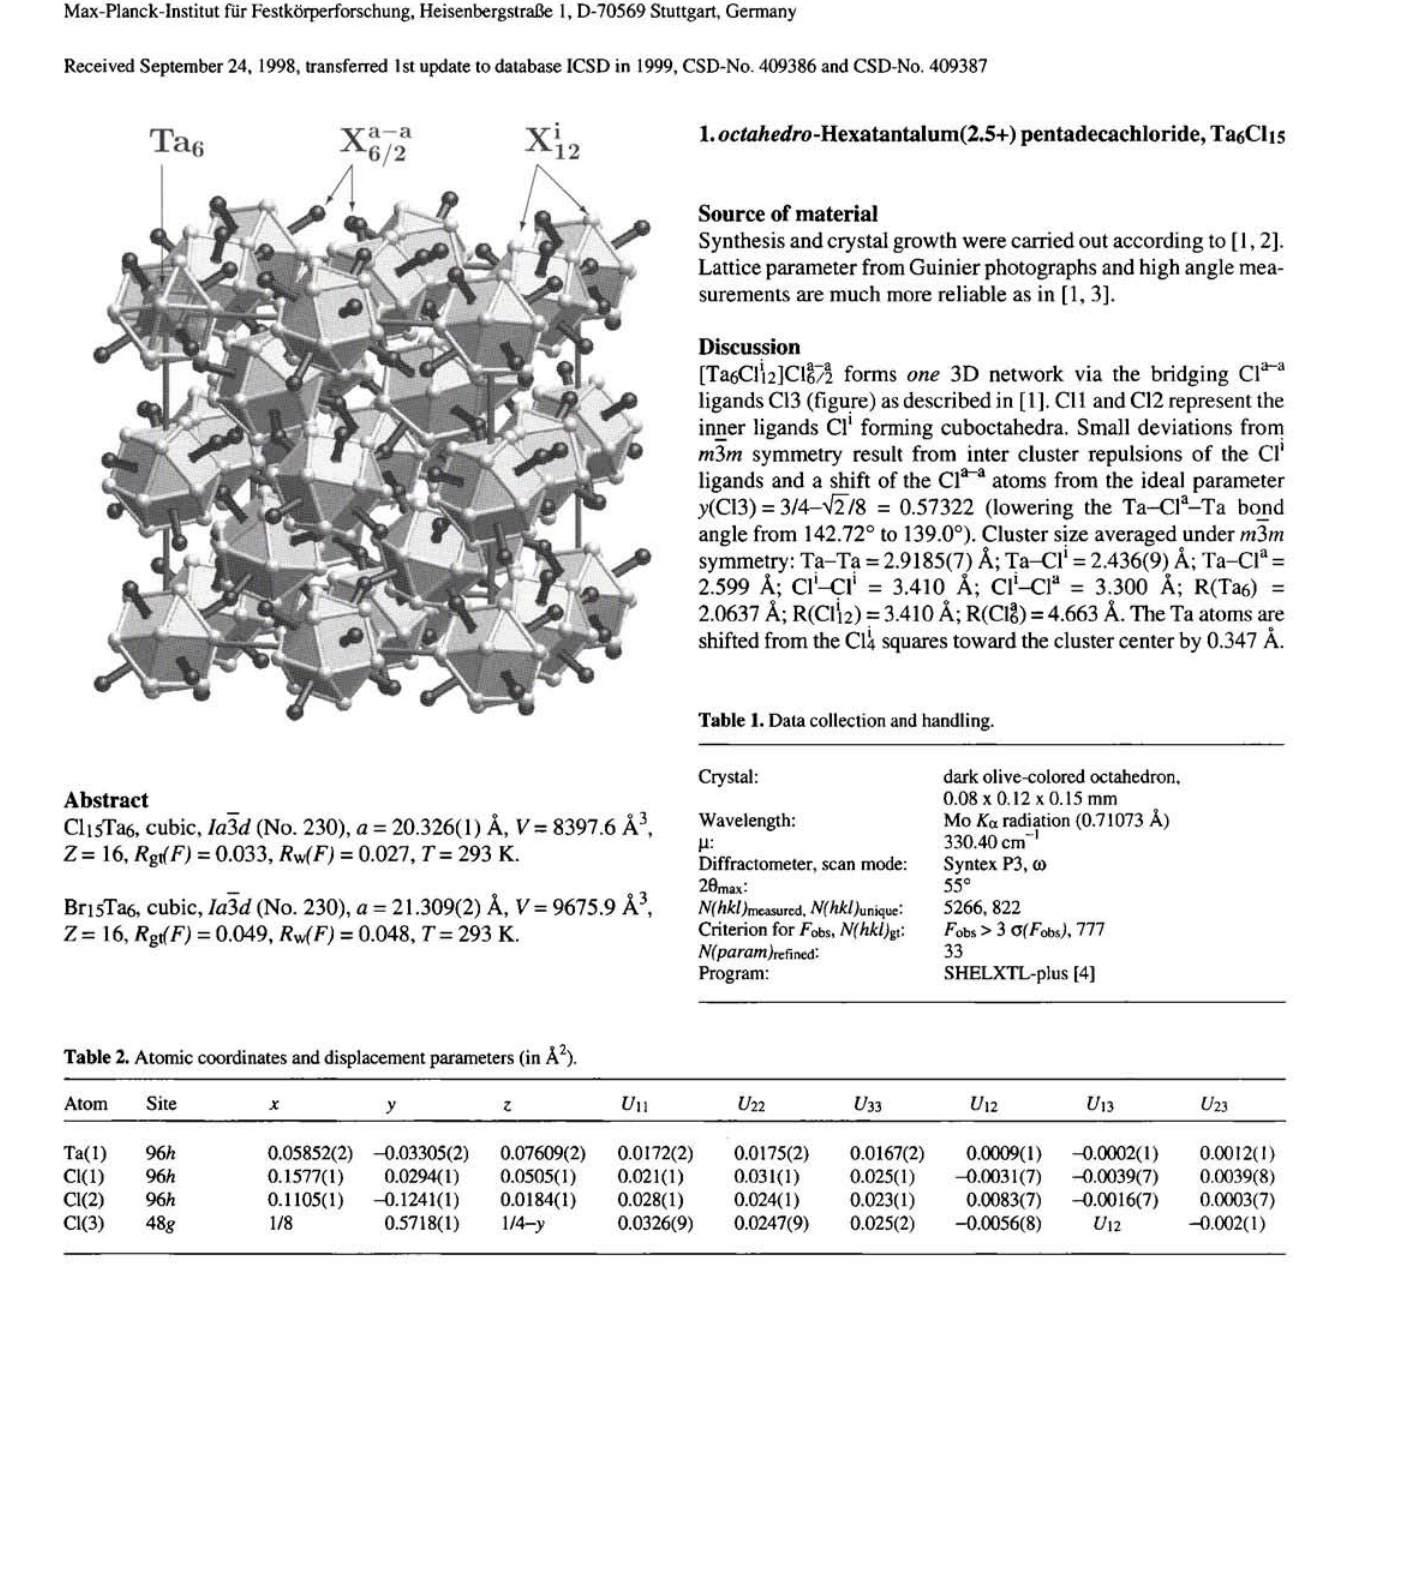
Table 2. Atomic coordinates and displacement parameters (in Â 2